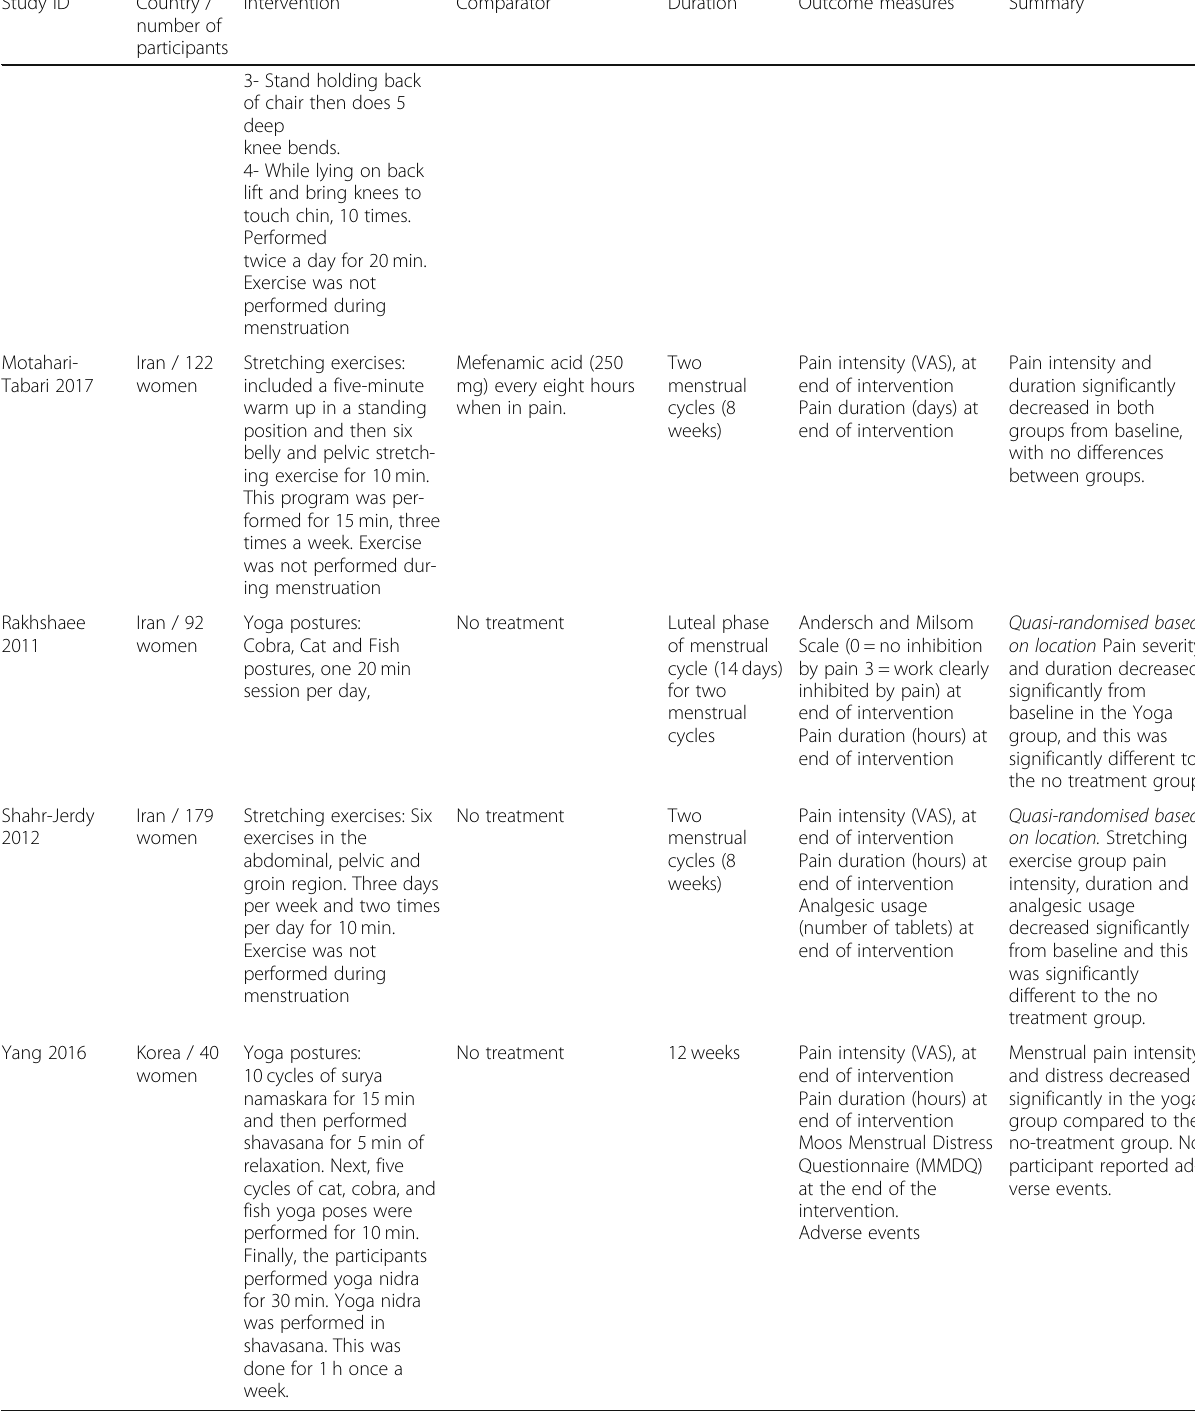
Table 1 Characteristics of included studies